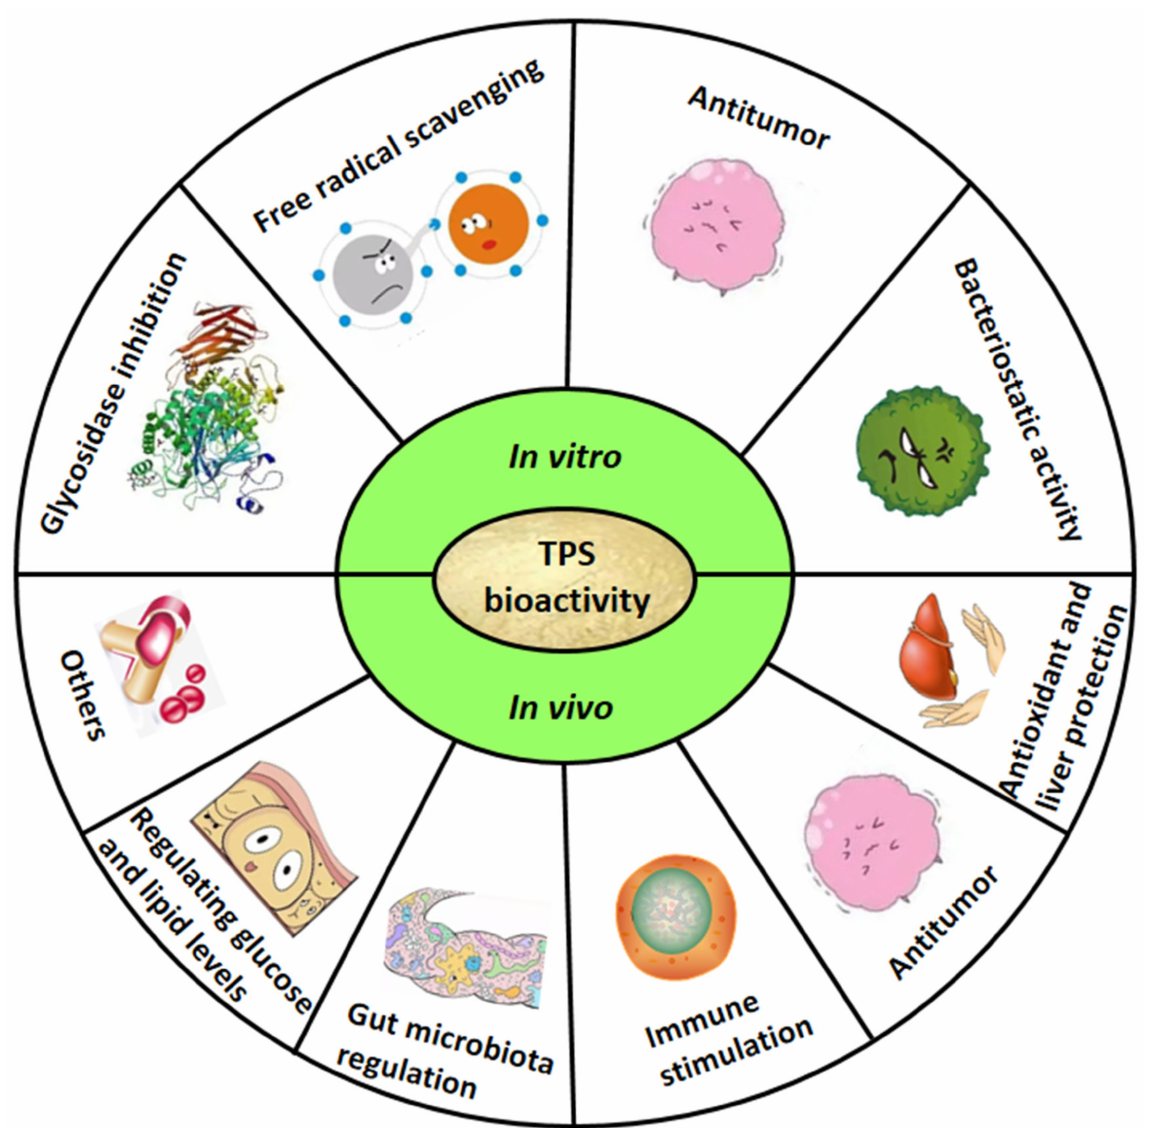
Figure 2. In vitro and in vivo bioactivities of